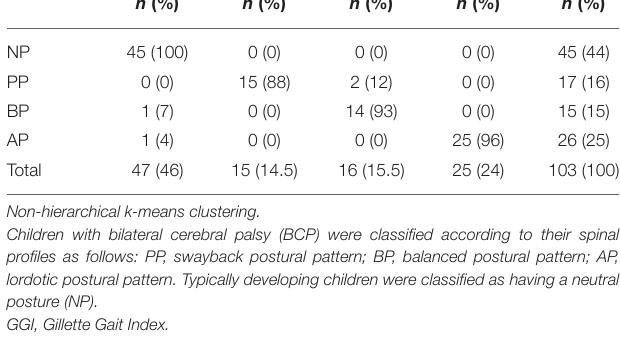
GGI, Gillette Gait